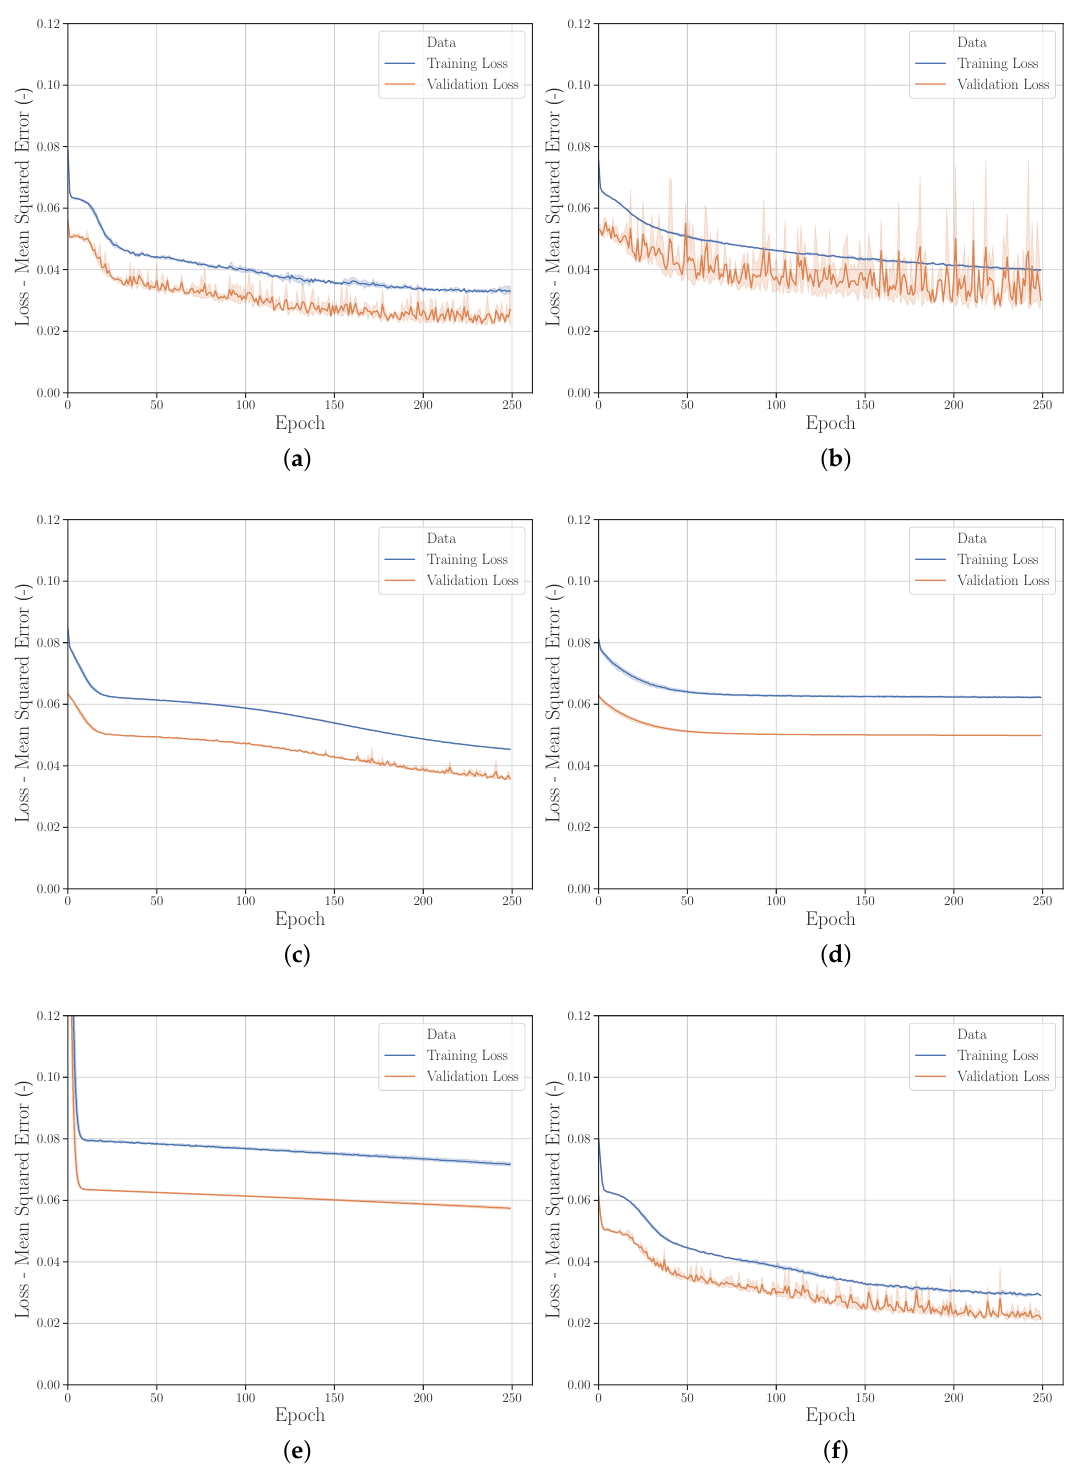
Figure A1. Learning curves with optimizer ( a ) Adam and ( b ) Rmsprop , ( c ) SGD , ( d ) Adagrad , ( e ) Adadelta and ( f ) Adamax